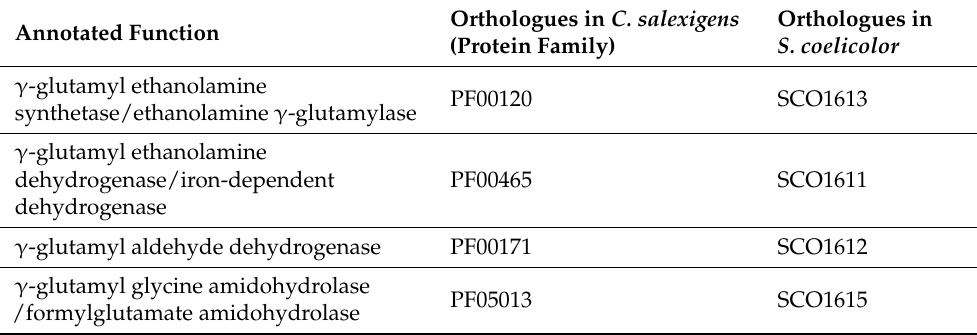
Table 2. Combined list of enzymes involved in ethanolamine utilization in C. salexigens and S. coelicolor